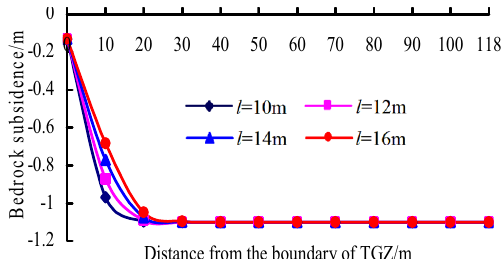
Figure 11. Bedrock subsidence vs. l in TGZ.